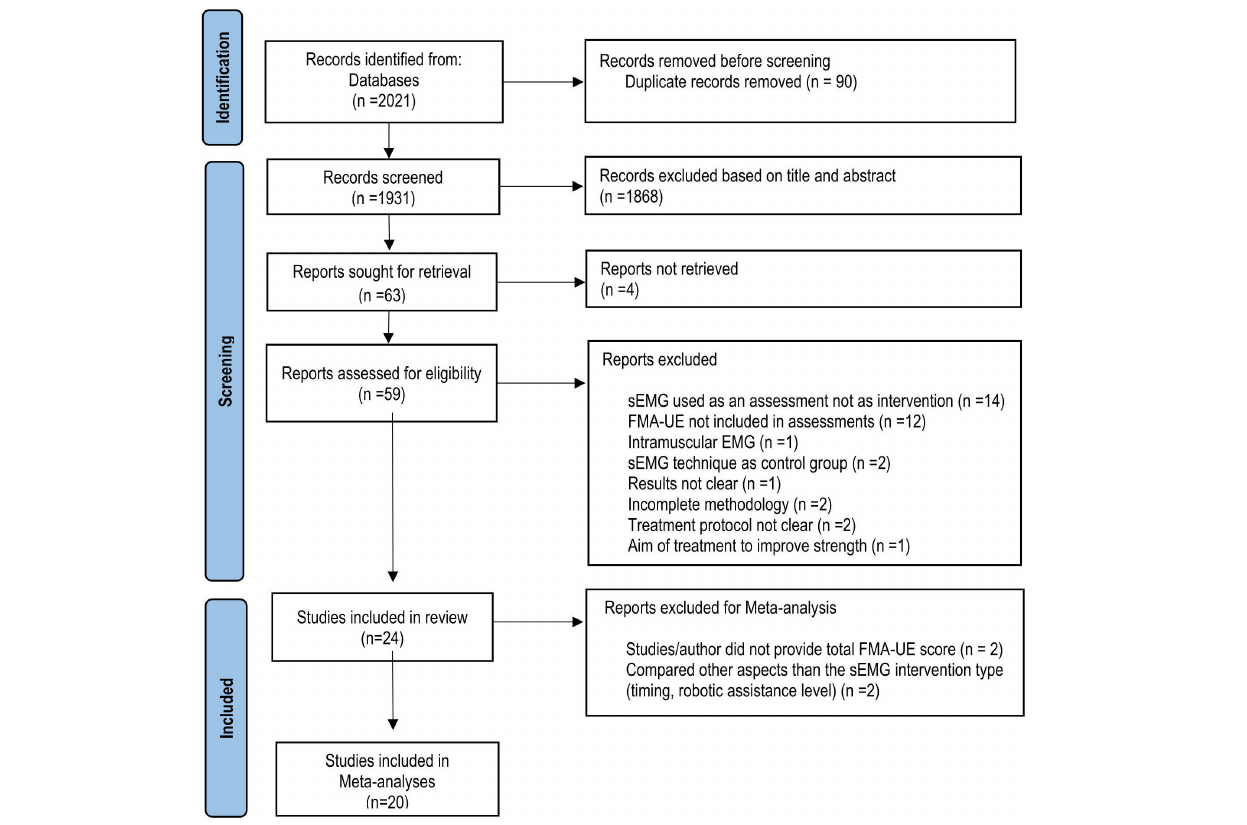
FIGURE 1 | Flow chart (PRISMA) of study selection. RCT, Randomized clinical trial; sEMG; surface electromyography, FMA-UE, Fugl-Meyer Assessment for the upper extremity.